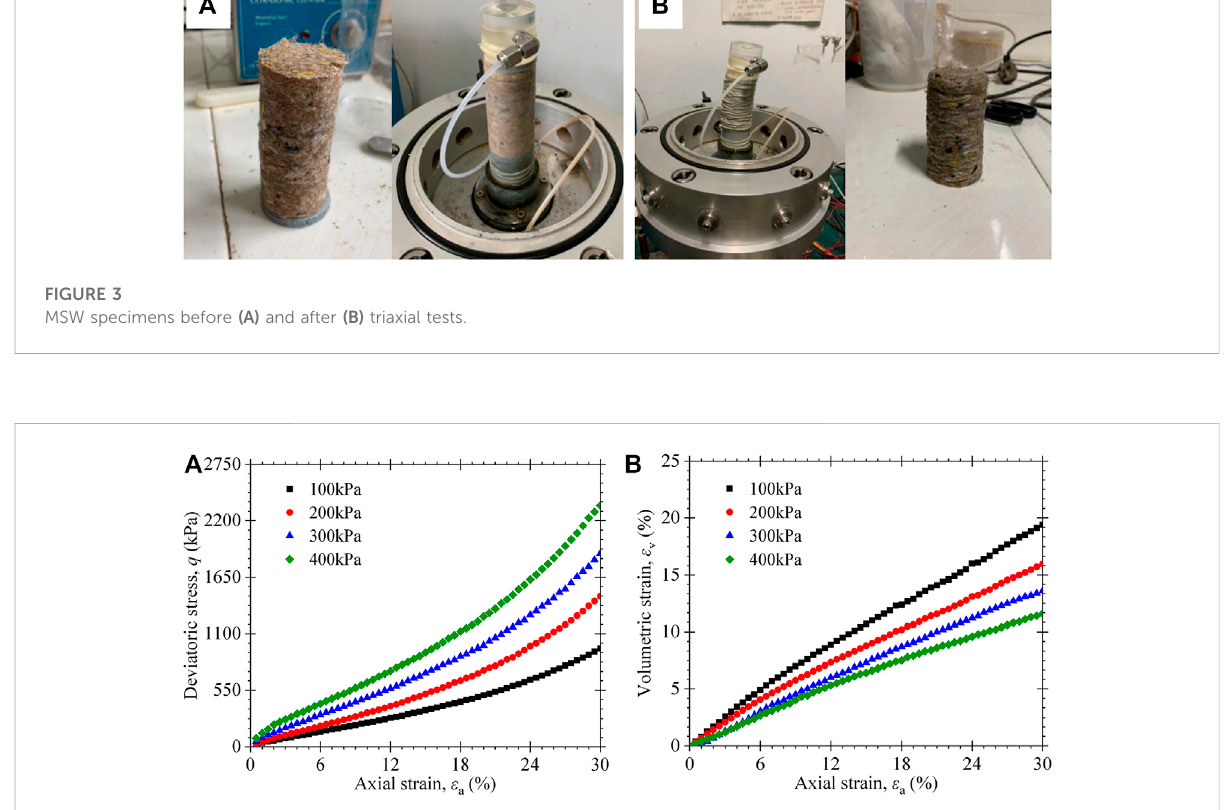
Under axisymmetric conditions, the mean normal effective stress p ′ and the deviator stress q are de fi ned as follows in Eq. 2.